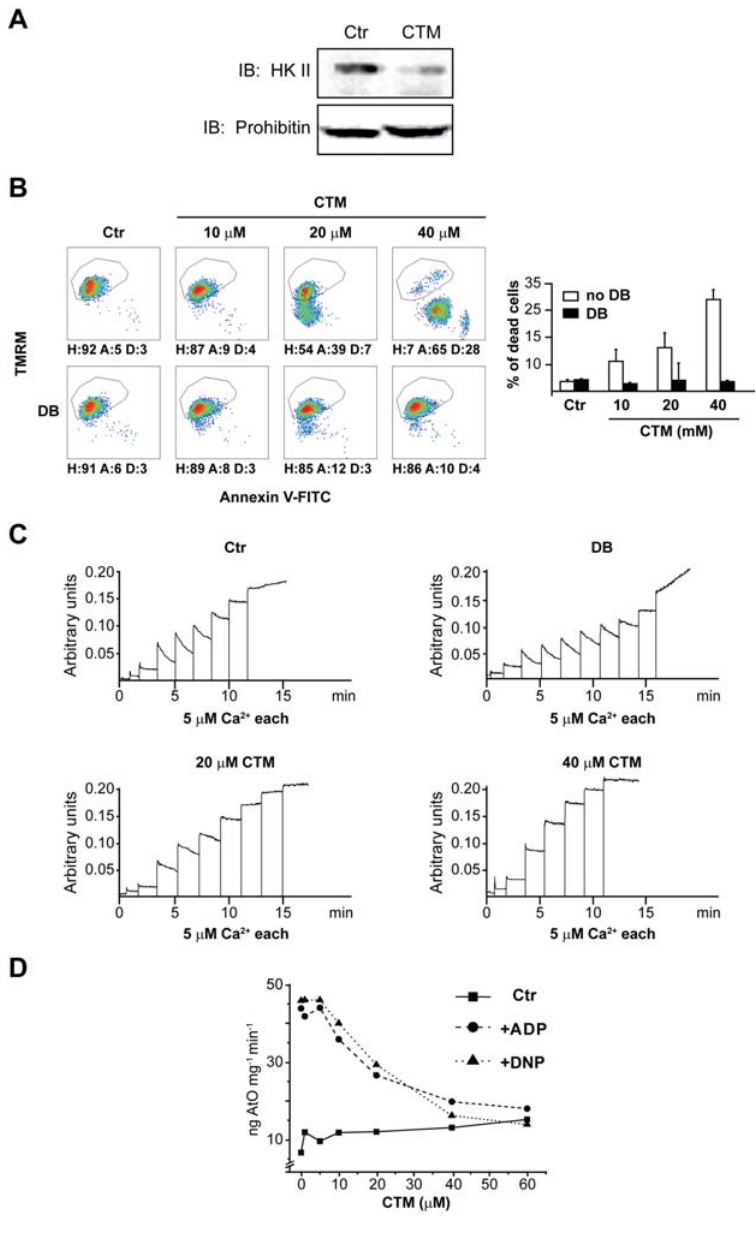
Figure 1. Effects of clotrimazole on cells and mitochondria. (A) HK II detachment from mitochondria following a 1 hour treatment with clotrimazole (CTM, 20 m M) was assessed by Western immunoblot on a mitochondrial fraction of HeLa cells. The blot was also probed with prohibitin as a mitochondrial marker and with actin as a cytosolic marker (negative, not shown), to check for fraction purity. (B) Output of multiparametric FACS analysis show apoptosis induction of HeLa cells exposed for 2 hours to several concentrations of CTM with or without pre-incubation with Debio 025 (DB, 8 m M). Healthy cells ( H ) are delimited by the quadrant. Apoptotic cells ( A ) display mitochondrial depolarization (reduced TMRM staining) and/or expose phosphatidylserine on their surface (increased Annexin V-FITC staining). Propidium iodide-positive, i.e. dead cells ( D ), were evaluated on a PI vs TMRM diagram (not shown); these cells were excluded from the reported plots and shown as histograms. Numbers are percentages. (C) PTP opening of digitonized HeLa cells measured with the Ca 2 + retention capacity assay. Calcium Green-5N fluorescence is reported as arbitrary units on the y axis. As the probe does not permeate mitochondria, Ca 2 + uptake into the organelles is displayed by a rapid decrease of the fluorescence spike. Pore inducers or inhibitors reduce or increase, respectively, the threshold Ca 2 + concentration required to trigger the permeability transition, i.e. the number of spikes before a sudden and marked fluorescence increase occurs. Experiments were started by the addition of digitonized cells (not shown) followed by pulses of the indicated concentrations of Ca 2 + . Where indicated, CTM was added to cells 45 minutes before permeabilization with digitonin. Note that CTM reduced the rate of Ca 2 + uptake into mitochondria. In the upper right plot DB was added before mitochondria to test the PTP-dependence of Ca 2 + release. (D) Respiration assay performed on mitochondria isolated from mouse liver. The graph shows the rate of oxygen consumption (ng AtO stands for ngatoms of oxygen) vs. different concentrations of CTM. The rate of respiration is displayed in basal conditions ( & ), after ADP administration ( N ) or after dinitrophenol administration ( m ). All reported results in the Figure are representative of at least four experiments.